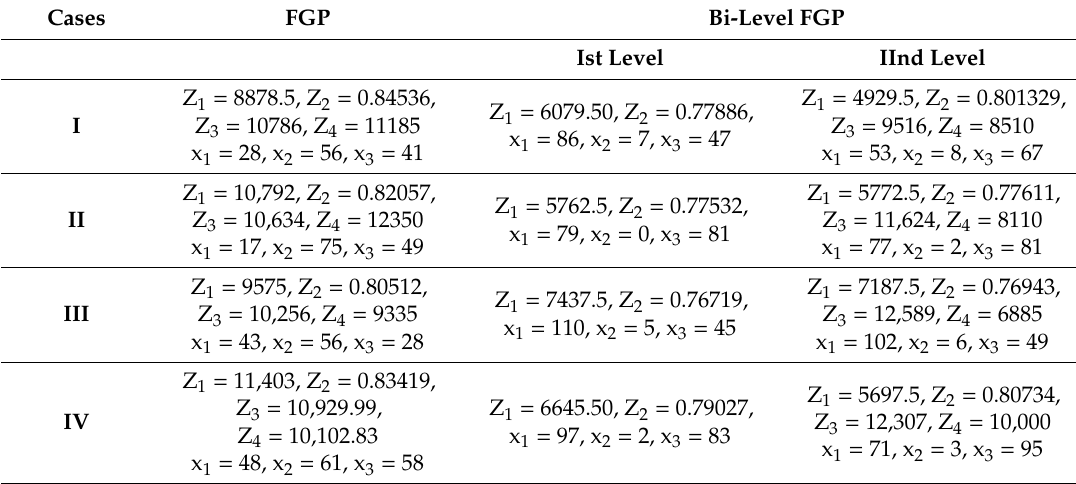
Table 3. A compromise solution to the problem.